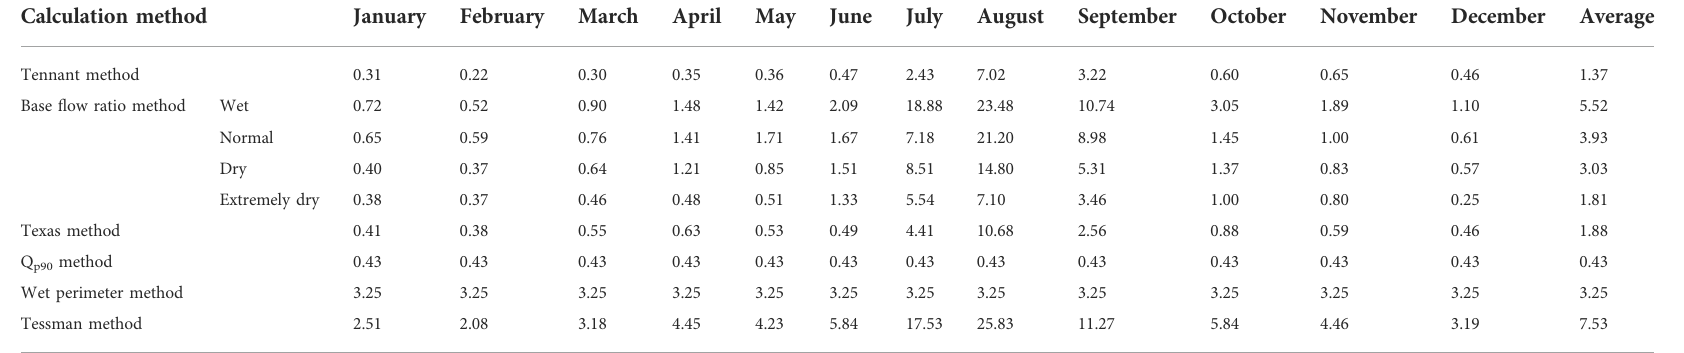
TABLE 4 Results of the ecological base fl ow with different calculation methods (Unit: m³/s).